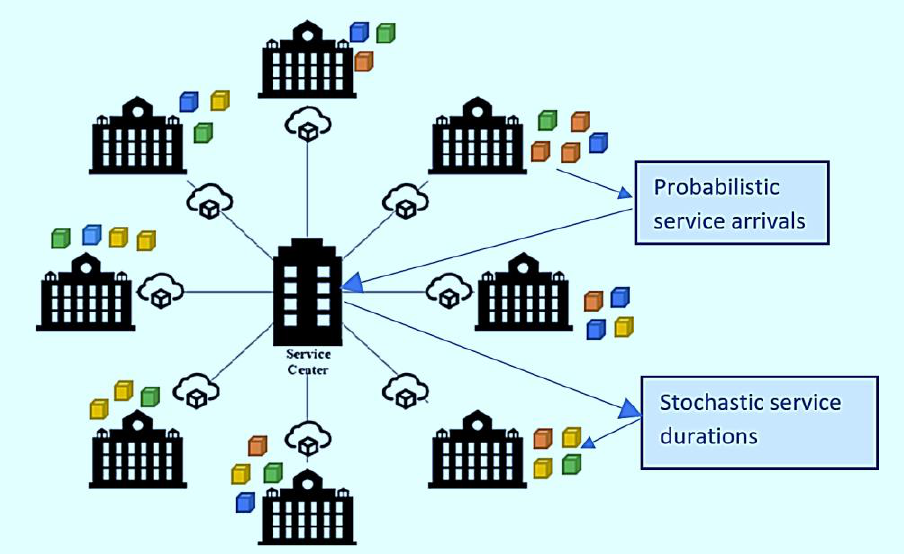
Figure 2. Service order tasks (blocks represent tasks).